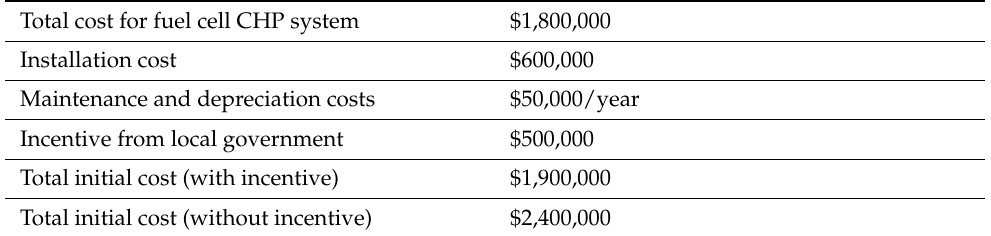
Table 5. Investigation of the investment and